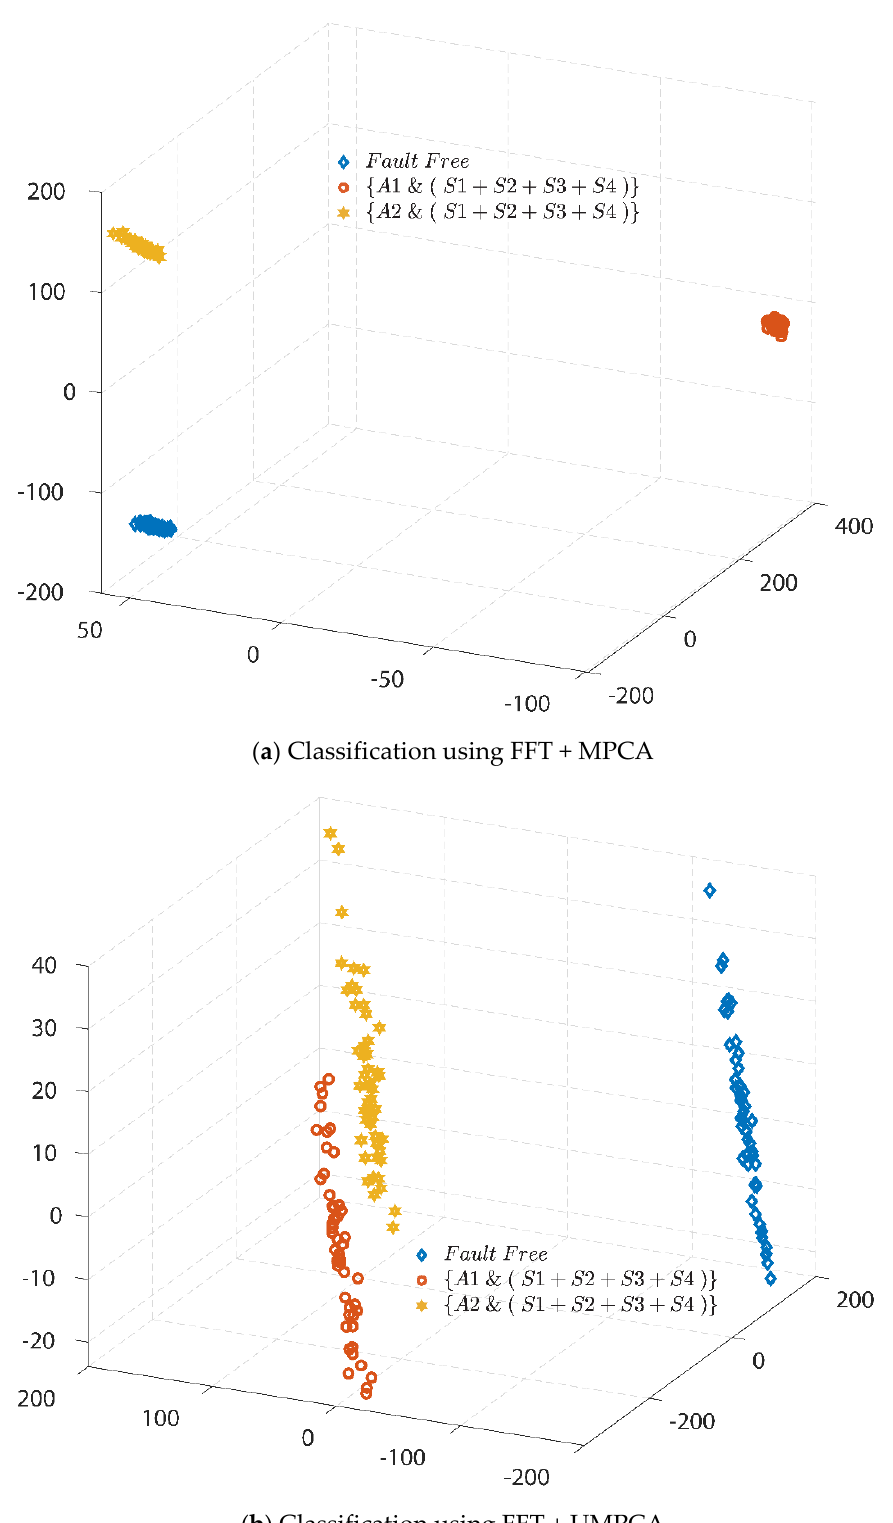
Figure 13. Three-dimensional space visualization performance for fault classification for wind turbines subjected to the single actuator and four sensor faults under AWGN noises, using ( a ) FFT + MPCA and ( b ) FFT + UMPCA, respectively.